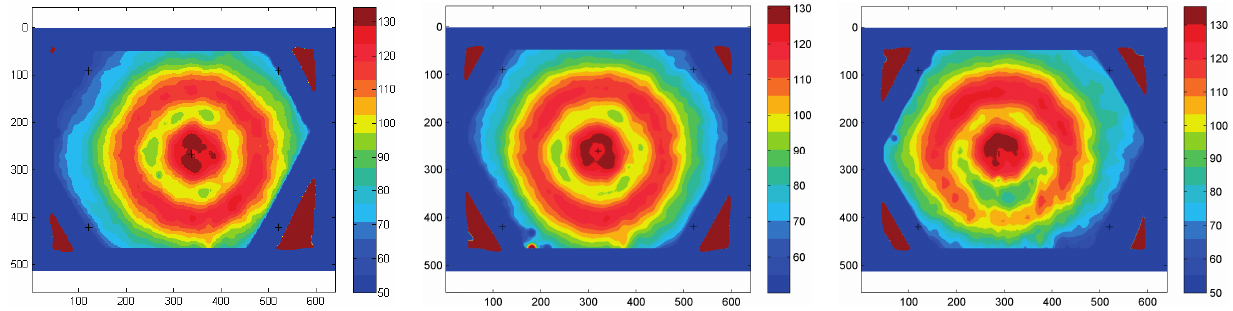
Figure 19. Nusselt number distribution for Re = 30,000 and z / D = 2. From left to right: